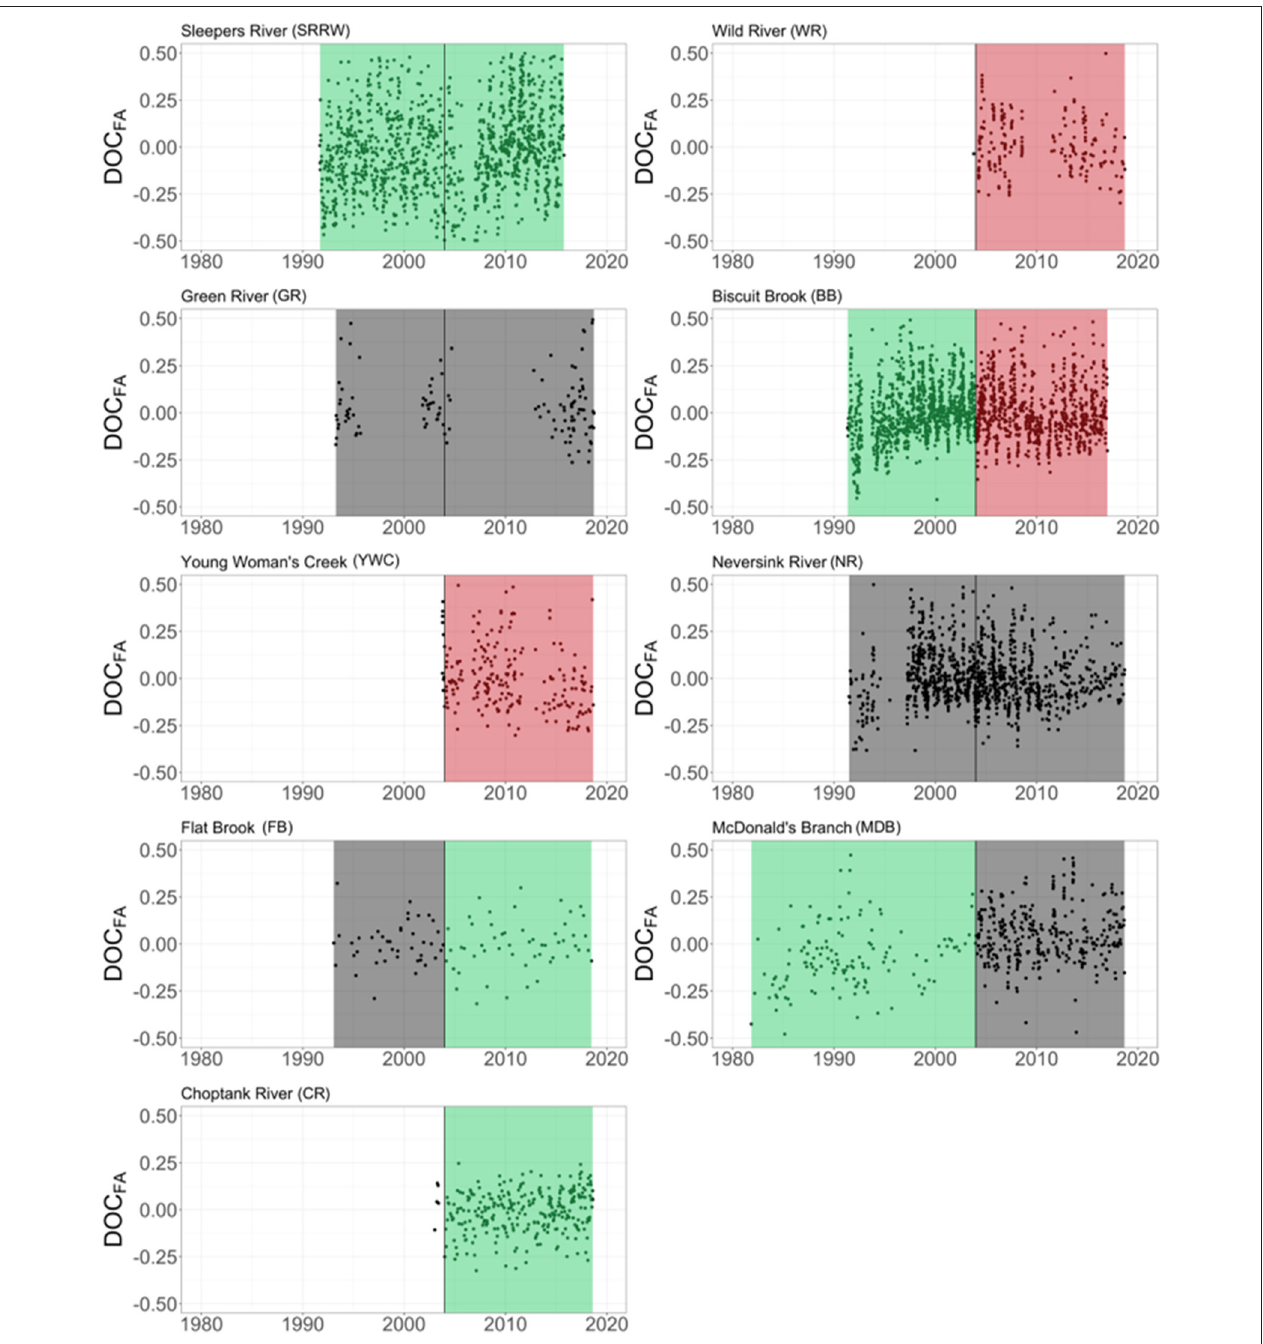
FIGURE 5 | Long-term trends in flow-adjusted DOC concentrat ions (DOC FA ). Trends are split between two periods of time: prior to 2004 and after 2004. Statistically significant ( α ≤ 0.05) positive trends are shaded in green, statistically significant negative trends are shaded in red, and no trend are shaded in gray.